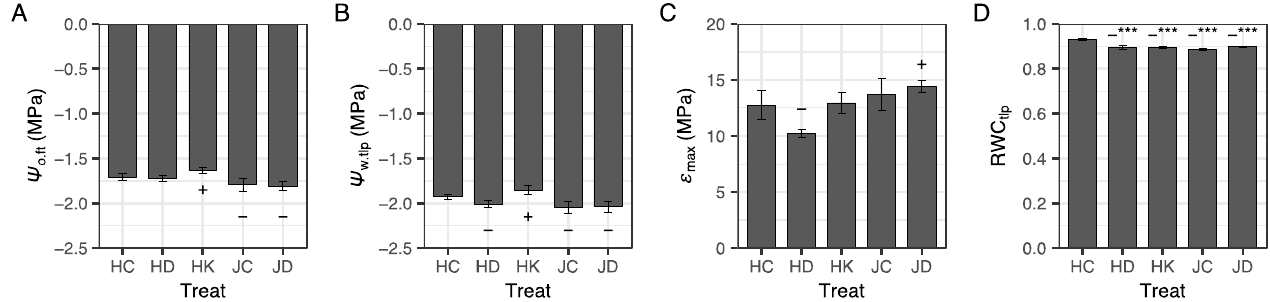
Figure 2. Mean values ± standard error (SE; n = 5) for leaf water relation parameters of container seedlings grown in Hiko-V-120 (H) and JFA-150 (J) containers with control irrigation and fertilization (HC and JC), dry irrigation (HD and JD), and high-potassium fertilization (HK). ( A ) Ψ o.ft , osmotic potential at full turgor; ( B ) Ψ w.tlp , leaf water potential at turgor loss point; ( C ) ε max , bulk modulus of elasticity; ( D ) RWC tlp , relative water content at turgor loss point. The plus and minus signs indicate positive and negative effects compared with the HC treatment in the linear model. *** p < 0.001.